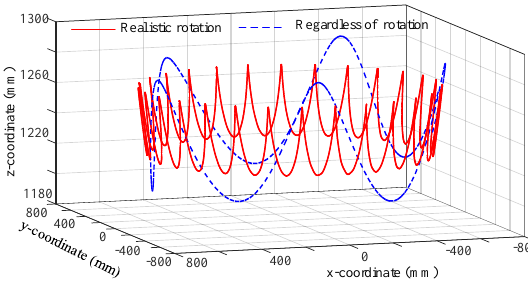
Figure 19. Comparison of the trajectory between real and regardless of rotation upon the mantle axis.